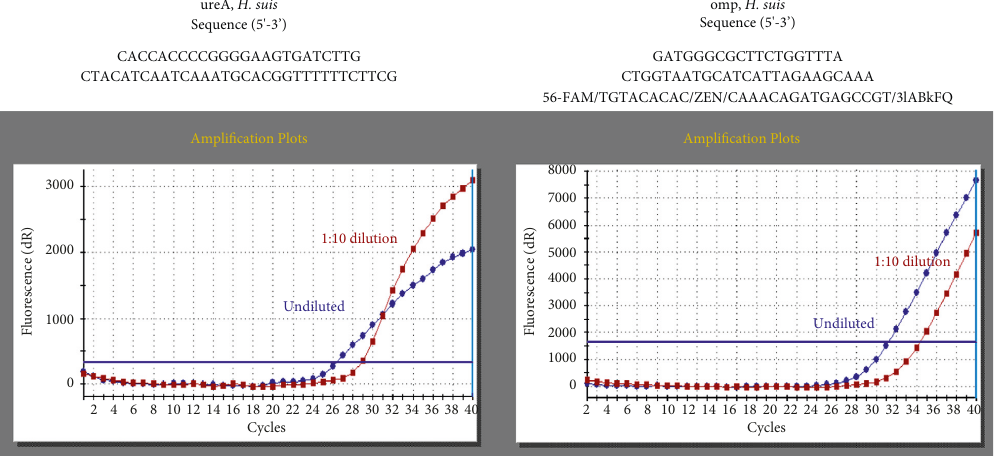
Figure 3: PCR analysis. The presence of H . suis is confirmed using H . suis -specific real-time PCR, targeting ureA and outer membrane protein genes.